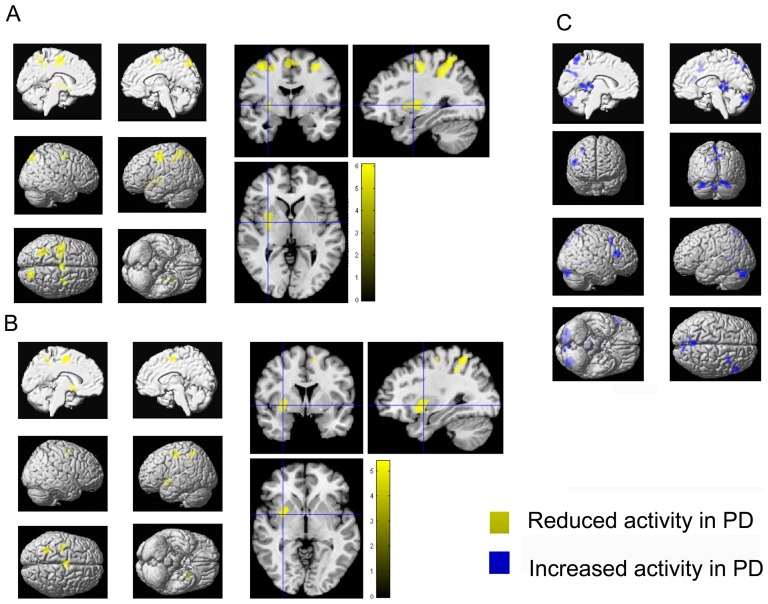
Functional working-memory related correlates in PD and controls during direct and delayed recall.
A–C) Regions showing significantly lower activity (yellow) in PD relative to healthy controls during A) direct recall and B) delayed recall. C) Regions showing significantly higher activity (blue) in PD relative to healthy controls during delayed recall. All significant effects are displayed on the MNI single subject template and the color bar represents T-values.